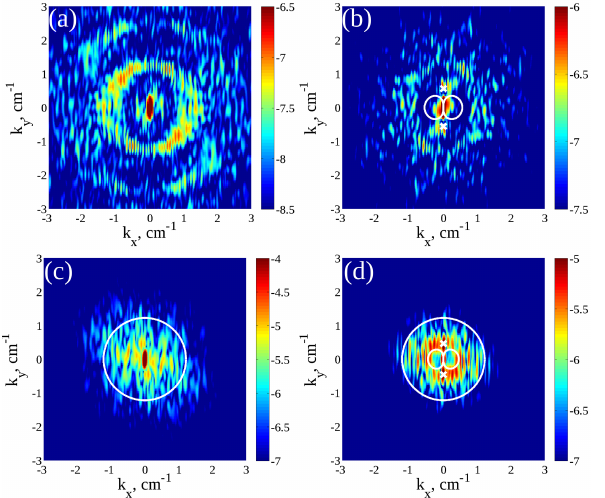
Figure 5. The one-dimensional energy spectra in log-log scale for the experiments with thermal (a) and saline (b) forcing: Figure 4. Energy spectra in the wavenumber space ( k x , k y ) for t = 630s (a) , 722s (b) (as in Fig. 4b and the experiments with thermal (a, b) and saline (c, d) forcing: t = 30s (a) , 630s (b) from the beginning of the thermal experi- ment; t = 10s (c) , 722s (d) after the fresh water source stopped in the experiment with saline forcing. Colour shows energy in loga- rithmic scale. Black circles in (c) and (d) show R − 1 . Black crosses d in (b) and (d) represent the Rhines scale wavenumber (5), while the dumbbell-shaped curve is given by Eq. (6).